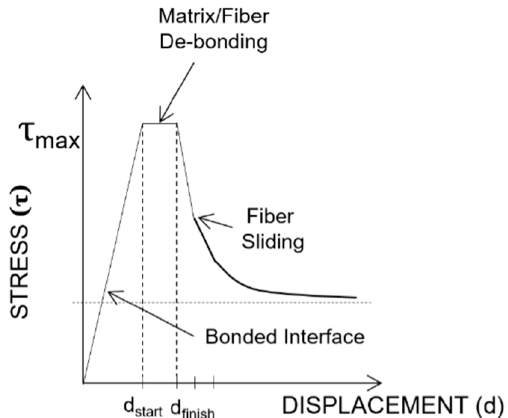
Figure 4. Schematic description showing the relationship between the applied stress and displacements in the pullout process of Ni/Ti SMA wires embedded into the cement matrix.